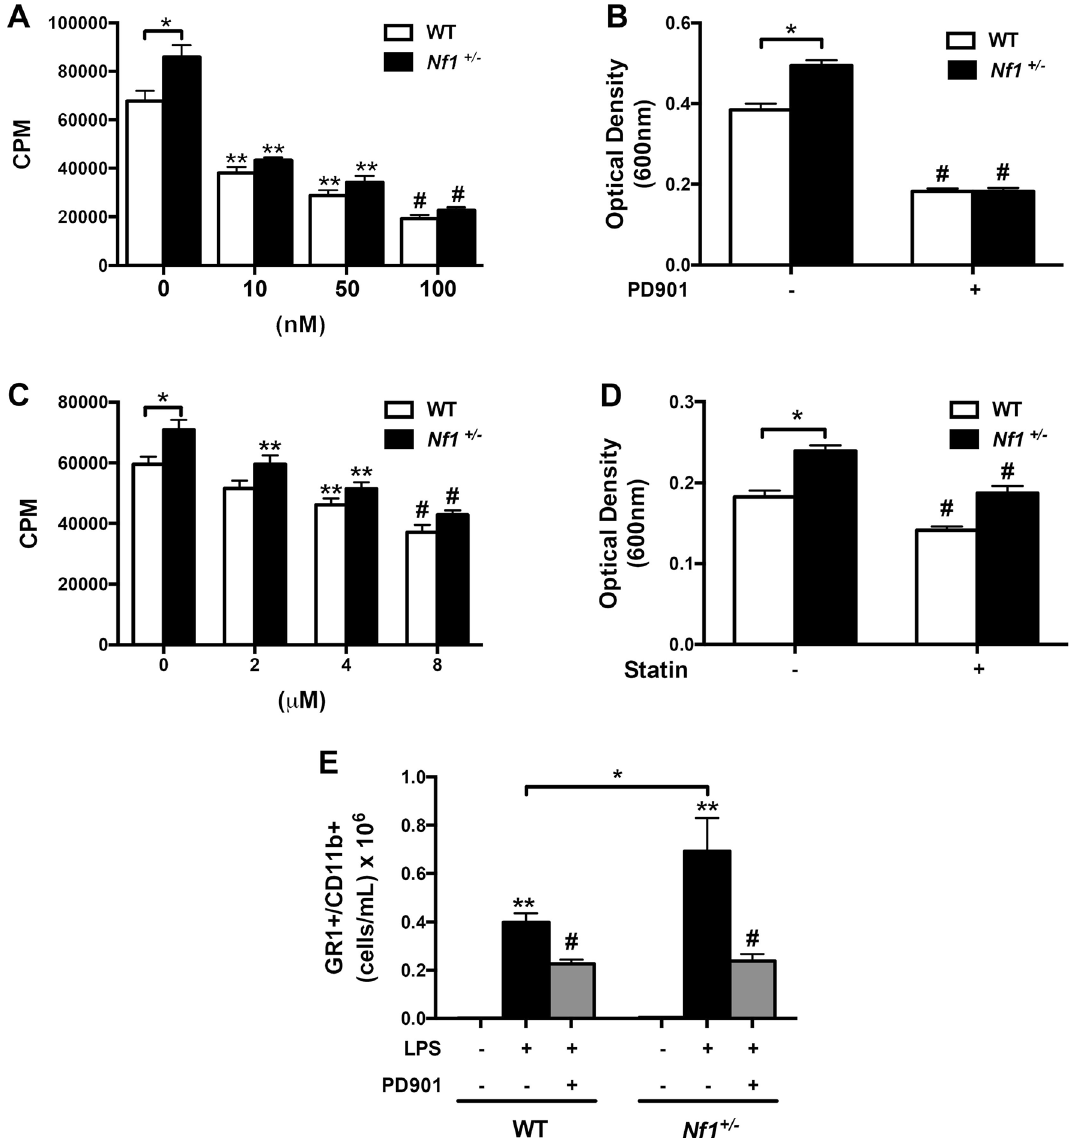
Figure 2. MEK inhibition impairs neurofibromin-deficient neutrophil function. ( A–D ). Quantification of WT (white bars) and Nf1 +/– (black bars) neutrophil proliferation ( A and C ) and adhesion ( B and D ) in response to G-CSF in the presence of PD901 ( A and B ) or rosuvastatin ( C and D ). ( A ) Data represent thymidine incorporation reported as mean counts per minute (cpm) ± SEM, n = 4–5. * P < 0.01 for WT versus Nf1 +/– neutrophils. ** P < 0.001 for WT and Nf1 +/– neutrophils versus WT and Nf1 +/– neutrophils incubated with indicated concentration of PD901. # P < 0.01 for WT and Nf1 +/– neutrophils incubated with 10 nM and 50 nM PD901 versus WT and Nf1 +/– neutrophils incubated with 100 nM PD901. ( B ) Data represent mean optical density (600 nm) ± SEM, n = 4–5. * P < 0.001 for WT versus Nf1 +/– neutrophils. # P < 0.001 for WT and Nf1 +/– neutrophils versus WT and Nf1 +/– neutrophils incubated with 50 nM PD901. ( C ) Data represent thymidine incorporation (cpm) ± SEM, n = 4–5. * P < 0.01 for WT versus Nf1 +/– neutrophils. ** P < 0.01 for WT and Nf1 +/– neutrophils versus WT and Nf1 +/– neutrophils incubated with indicated concentration of rosuvastatin. # P < 0.01 for WT and Nf1 +/– neutrophils incubated with 2 μM rosuvastatin versus WT and Nf1 +/– neutrophils incubated with 8 μM rosuvastatin. ( D ) Data represent mean optical density ± SEM, n = 4–5. * P < 0.001 for WT versus Nf1 +/– neutrophils. # P < 0.01 for WT and Nf1 +/– neutrophils versus WT and Nf1 +/– neutrophils incubated with 10 μM rosuvastatin. ( E ) Quantification of absolute number of GR1 + /CD11b + neutrophils in peritoneal lavage fluid 48 h after LPS injection with/without PD901. * P < 0.001 for WT versus Nf1 +/– mice. ** P < 0.001 for WT and Nf1 +/– mice without LPS injection versus WT and Nf1 +/– mice provided LPS. # P < 0.001 for WT and Nf1 +/– mice provided LPS versus WT and Nf1 +/– mice provide LPS with daily PD901. Analysis by 2-way